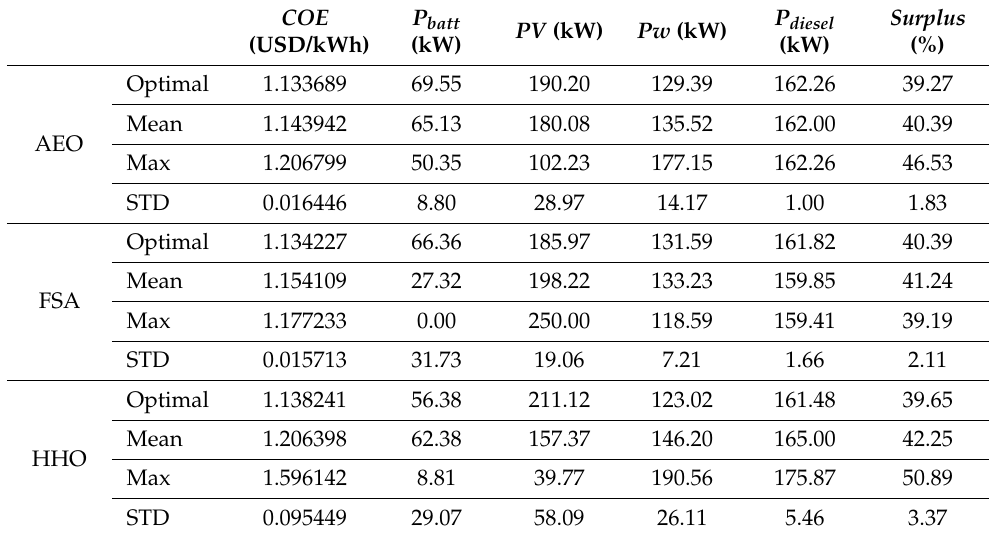
Table 3. Optimal, Minimum, Maximum, and STD for AEO, FSA, and HHO at 60% REF and LPSP of 0%.